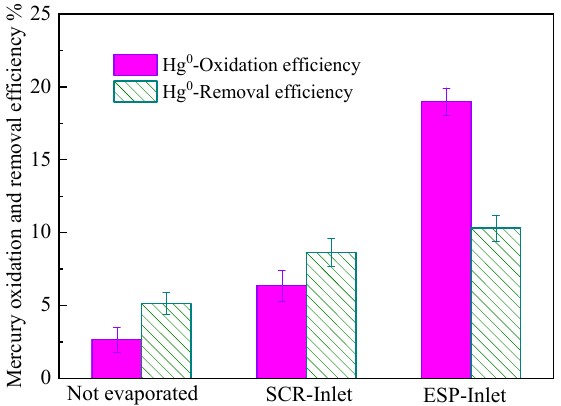
Figure 10. Effect of desulfurization wastewater evaporation on Hg removal by ESP. Table 5. Concentrations of Hg 0 and Hg 2+ at the inlet and outlet of different units of devices.